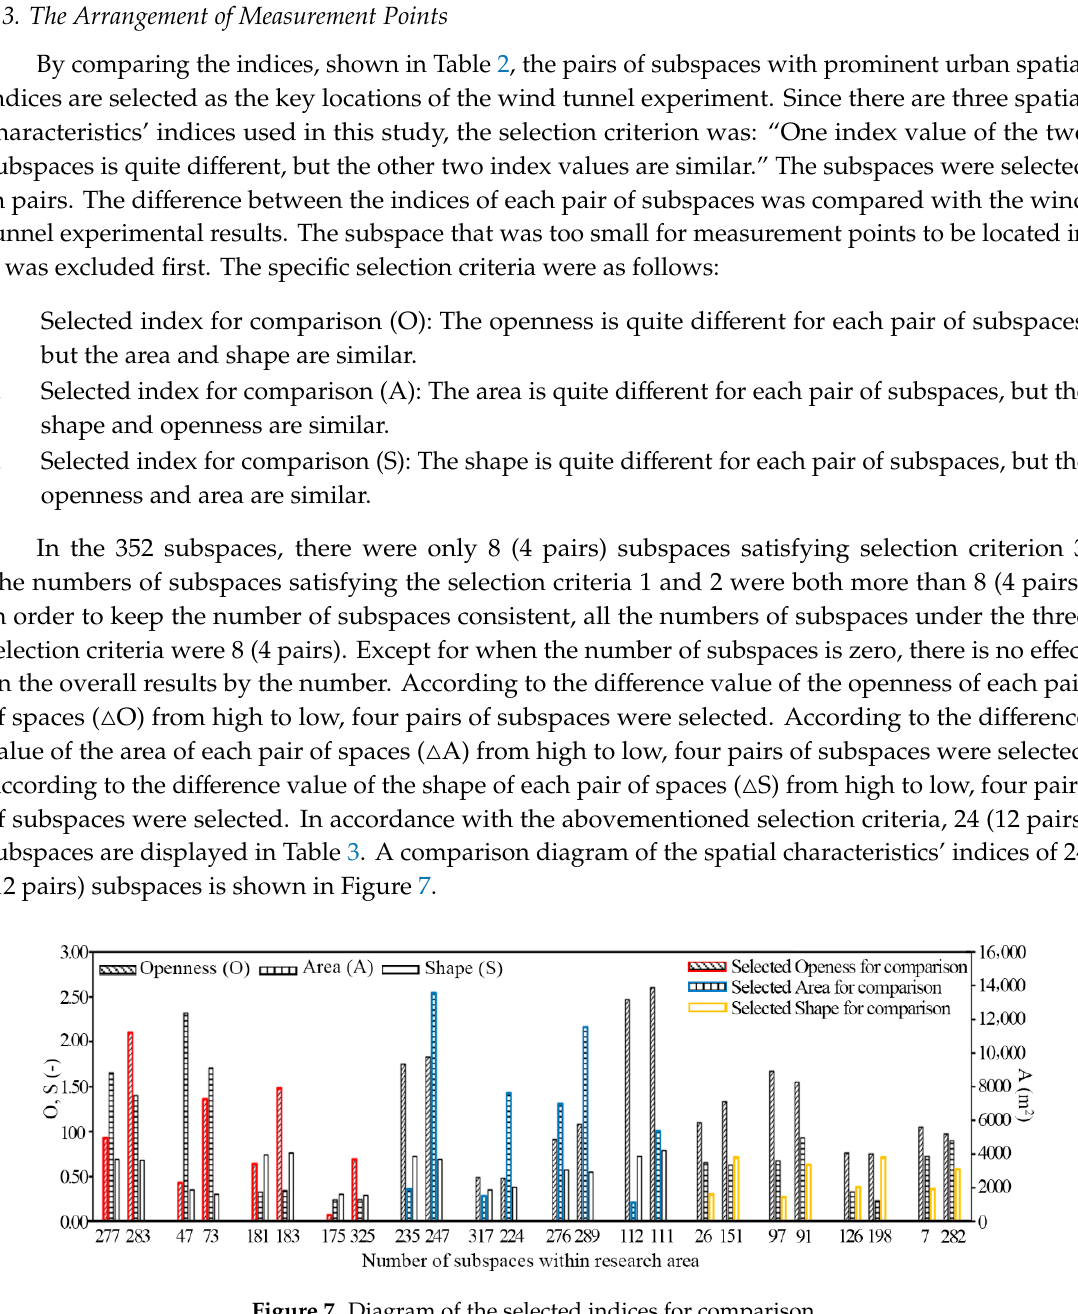
Figure 7. Diagram of the selected indices for comparison.